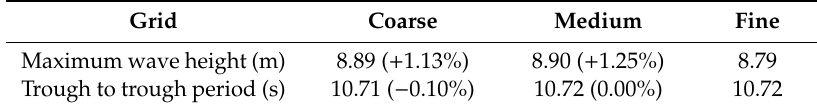
Table 3. Mesh sensitivity test under different mesh sizes.